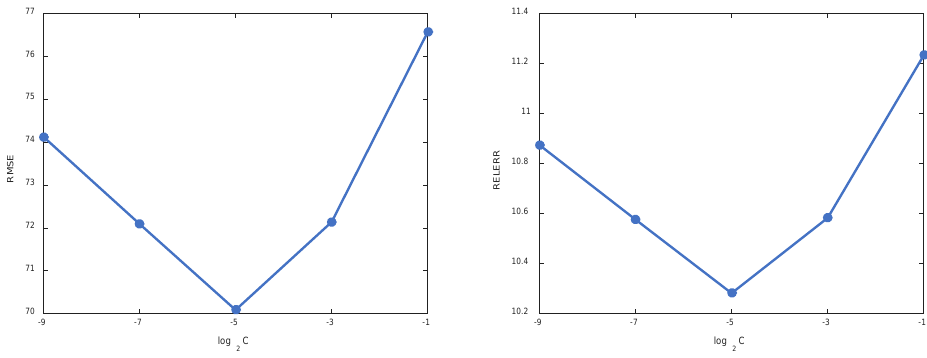
. Figure 8. Variation of sparsity w.r.t. different values of α . Sensors 2018 , 18 , x FOR PEER REVIEW 𝐶𝐶